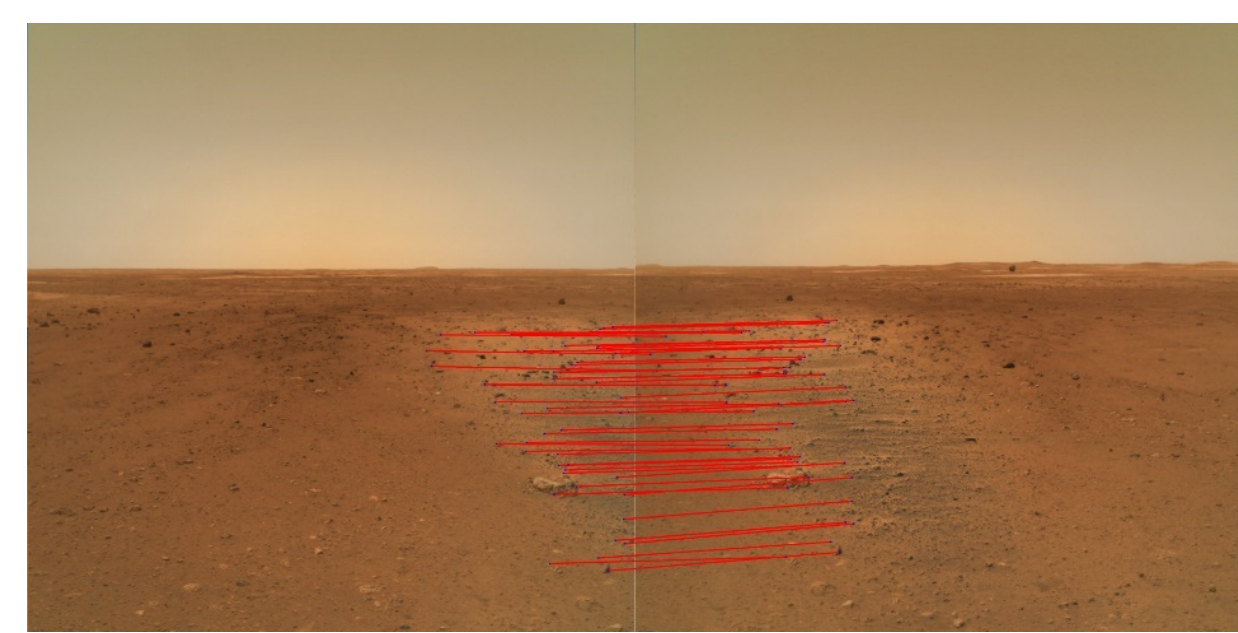
Figure 3. The SIFT matching result between adjacent NaTeCam images. The red lines link the corresponding matched points between adjacent NaTeCam images.